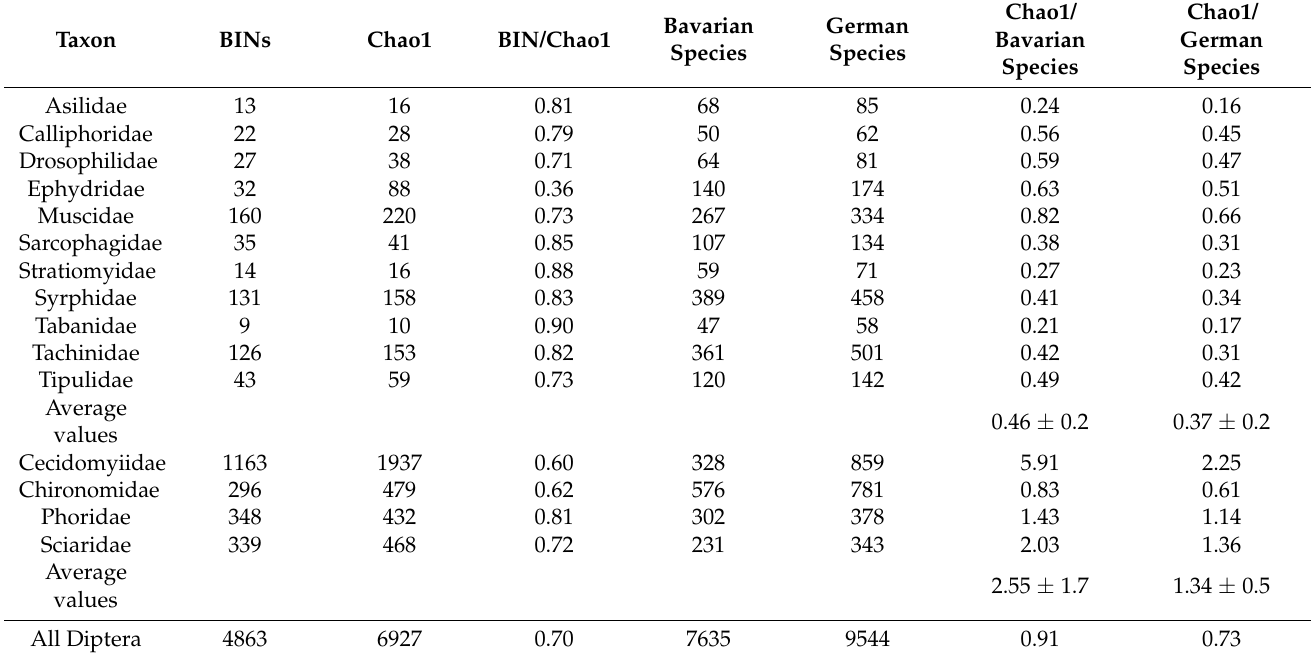
Table 5. Proportion of undocumented Diptera biodiversity for Bavaria and Germany based on Chao1 estimates for 15